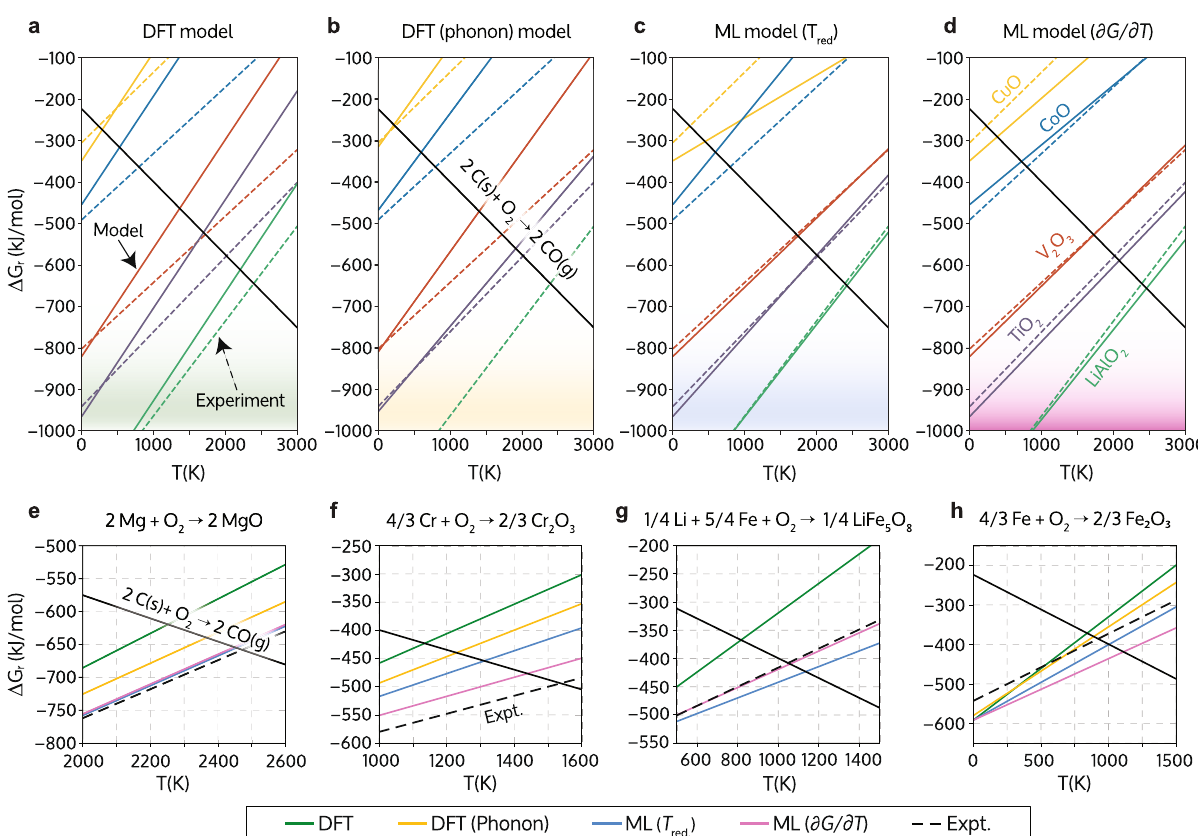
Fig. 3 Predicted reaction free-energy curves for different metal oxides and models. a – d Predicted Ellingham diagrams obtained from a density-functional theory (DFT), b DFT including phonon theory, c the machine-learning (ML) model trained on reduction temperatures, and d the hybrid ML model trained on metal oxide formation free-energy slopes ( ∂ G / ∂ T ). The labels for the different metal oxides are included in panel d . Predicted free-energy curves are represented by the solid colored lines whilst the dashed lines are the experimental reference values (Expt.). The free-energy curves for the formation of e MgO, f Cr 2 O 3 , g LiFe 5 O 8 , and h Fe 2 O 3 obtained from DFT (green), DFT using phonon corrections (orange) and the ML models trained on reduction temperatures (blue) and free-energy slopes (pink) are compared with their corresponding experimental reference data (black dashed lines). The black solid lines indicate the experimental free-energy curve for CO